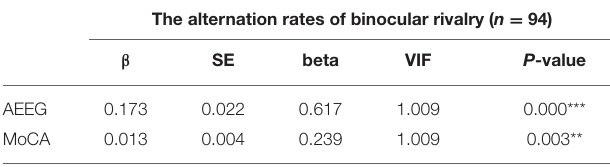
TABLE 4 | Summary of AEEG status, ASMs use, and correlations with rivalry TABLE 5 | Stepwise linear regression showing factors independently associated alternation rates in IGE patients. with rivalry rate in patients with IGE. Mean (SD) or r p- value The alternation rates of binocular rivalry ( n = 94)